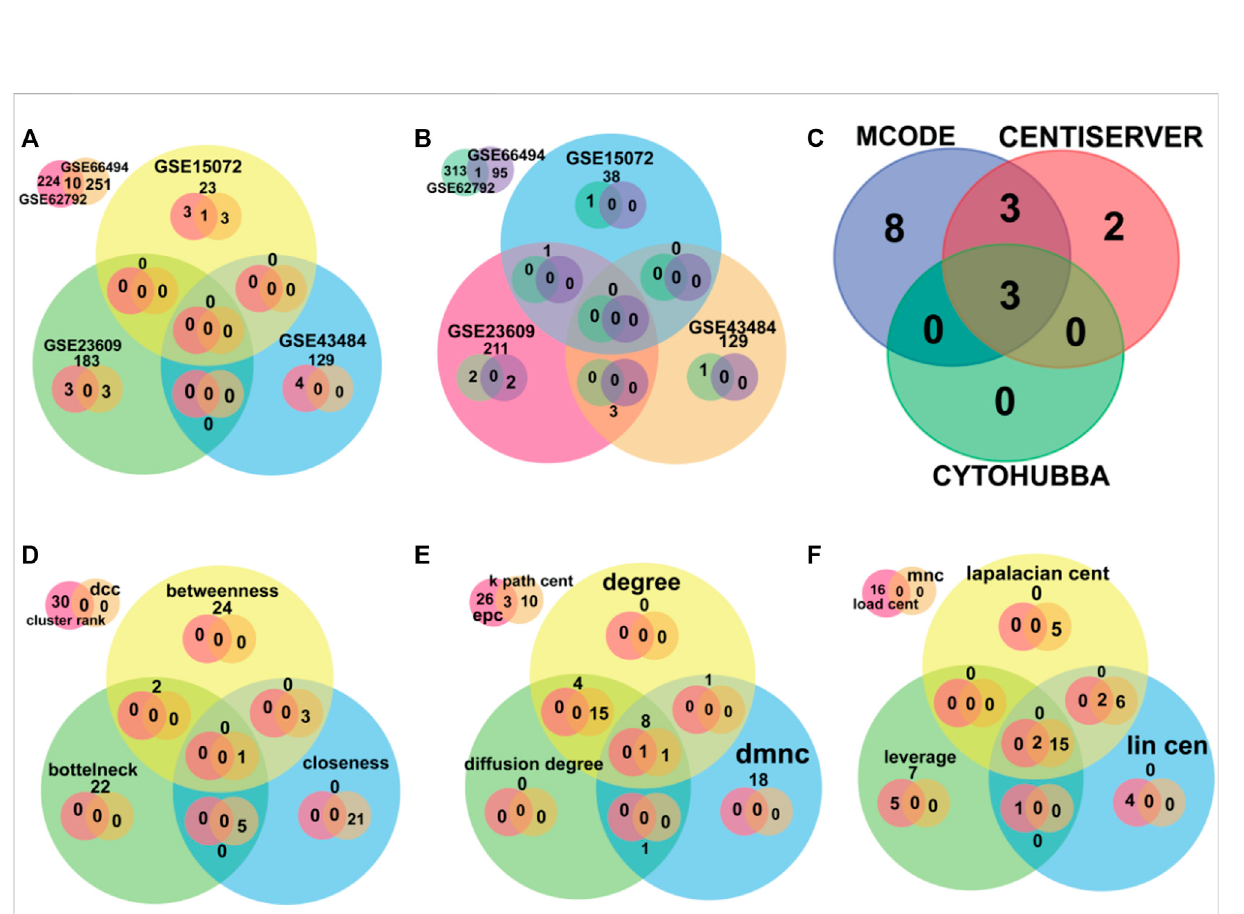
FIGURE 2 The Venn diagram depicts the overlapped data. (A,B) were used for fi nding overlapped DEGs upregulated and downregulated genes, respectively. (C) was used for fi nding the overlapped hub genes using software MCODE, Centiserver, and Cytohubba. (D – F) depict different centralities methods for overlapped